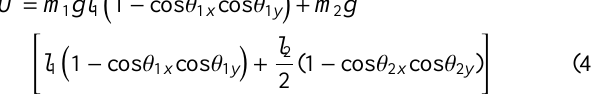
Fig.1: Representation of the 3D double pendulum gantry crane Figure 1. Representation of the 3-D double pendulum gantry